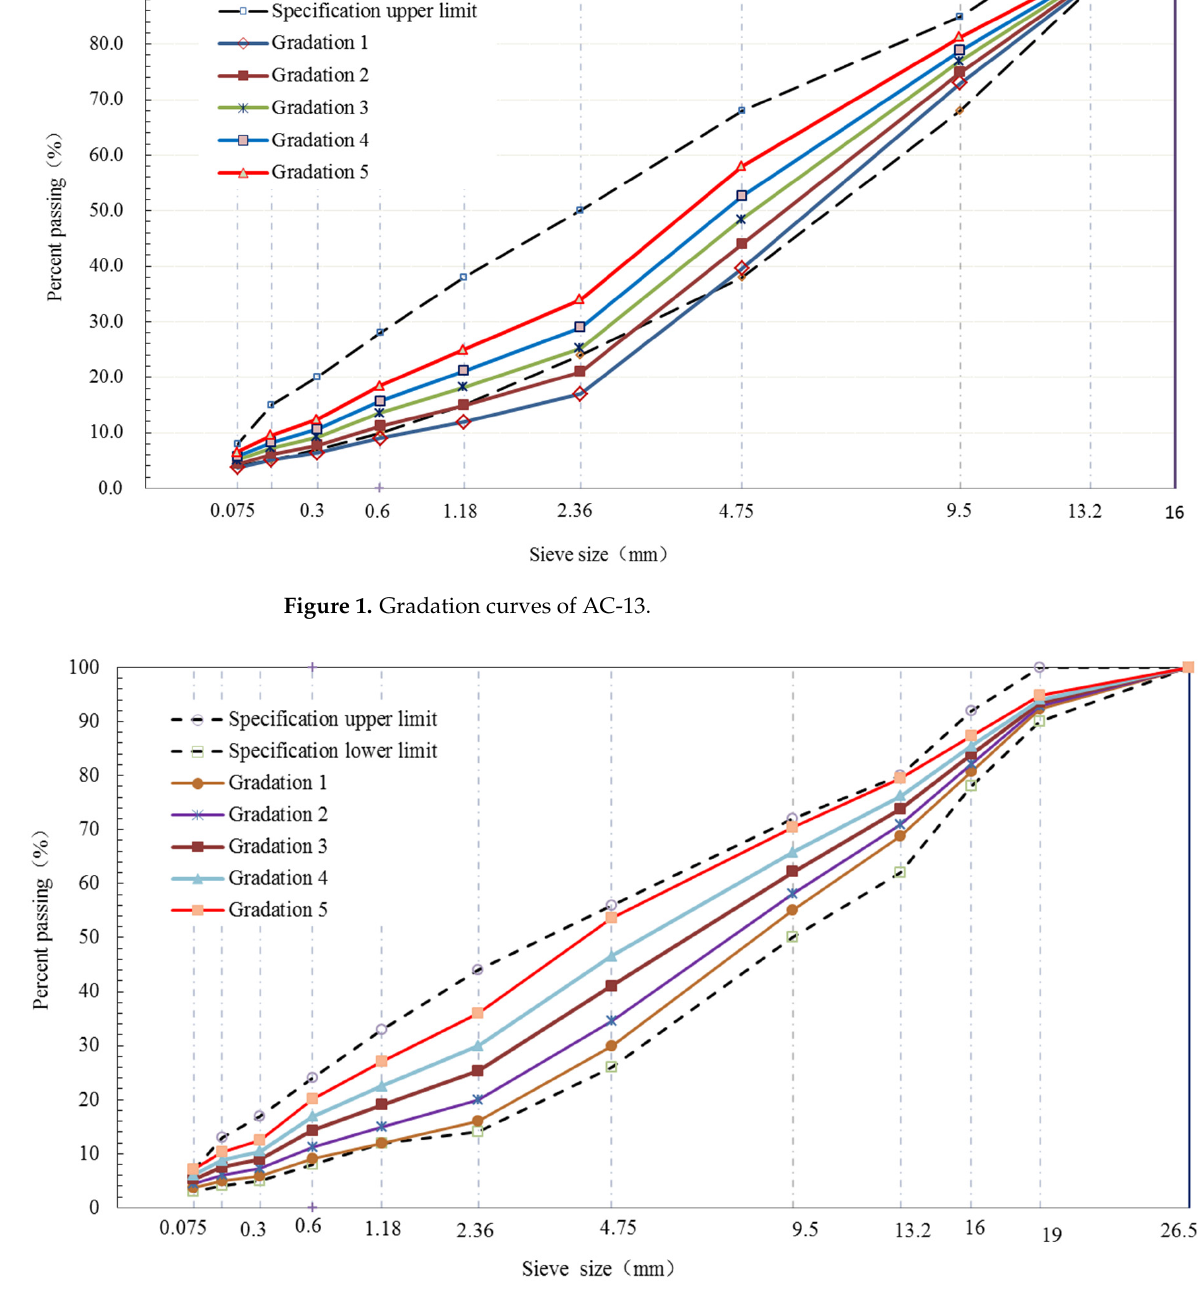
Figure 2. Gradation curves of AC-20.